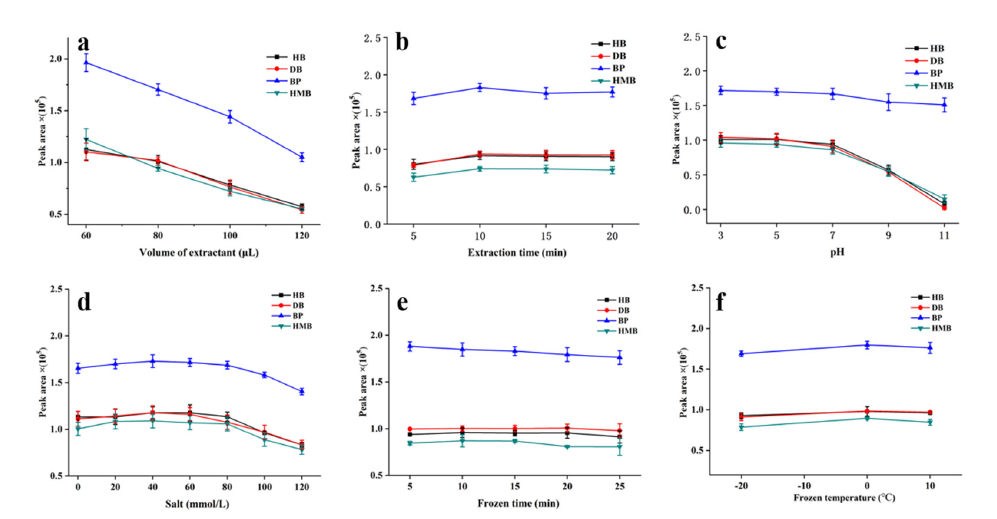
Figure 2. Optimization of extraction conditions. ( a ). volume of the extractant; ( b ). extraction time; ( c ). pH; ( d ). salt concentration; ( e ). solidification temperature; ( f ). solidification time.